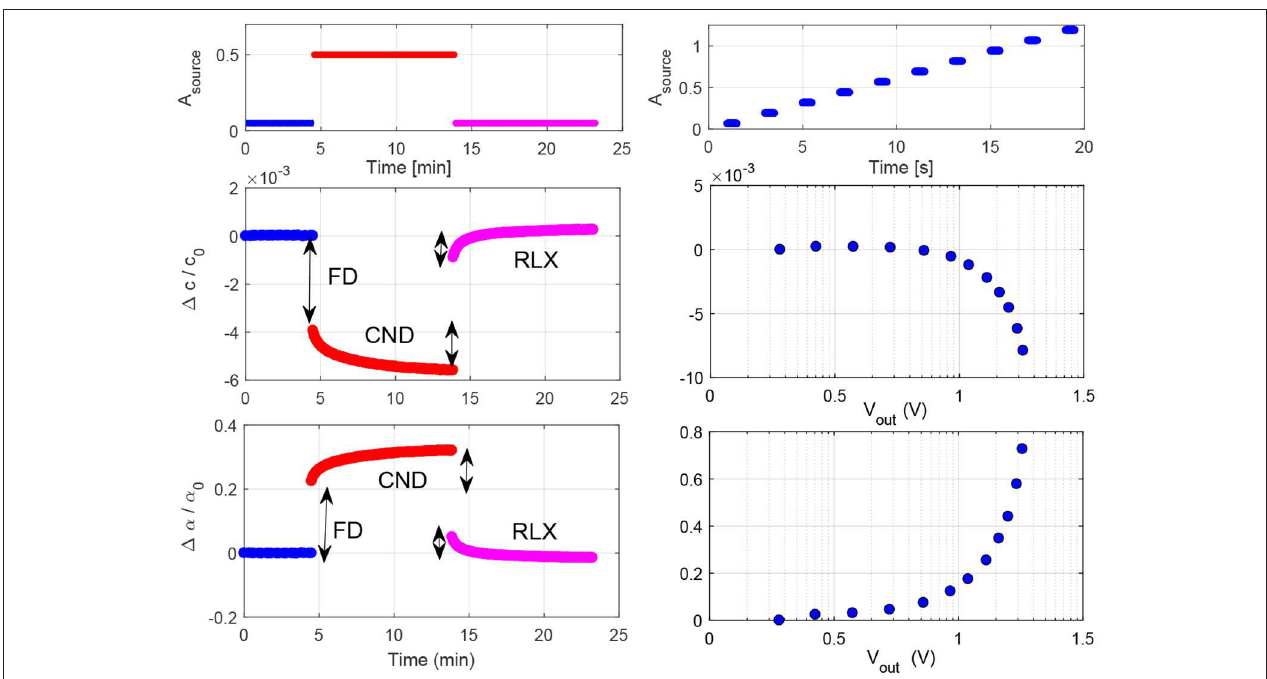
FIGURE 1 | Illustration of slow (left) and fast (right) processes. The sample is excited by a monochromatic wave at varying amplitude of excitation A source . The protocol of the choice of excitation level is shown in the upper row. The time/strain dependances of velocity and damping are shown in the second and third row, respectively. In the left column values, the instantaneous FD, the conditioning (CND) and the relaxation (RLX) phases are indicated. Here the symbol V out denotes the amplitude of the output signal, generally expressed in mV, which is proportional to the strain amplitude in the sample.